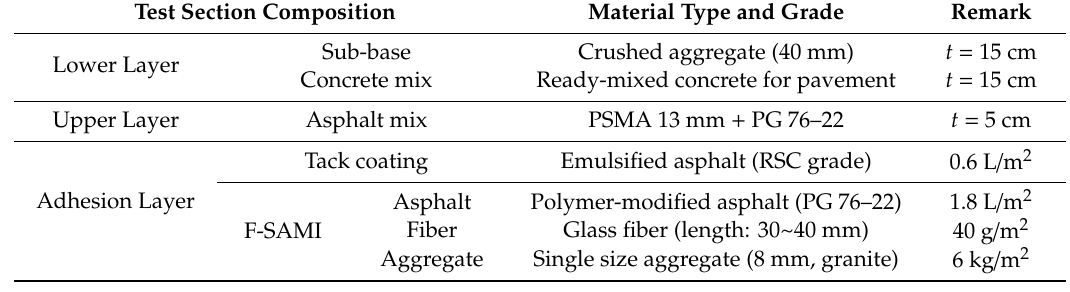
Table 4. Materials and grade for APT test section.